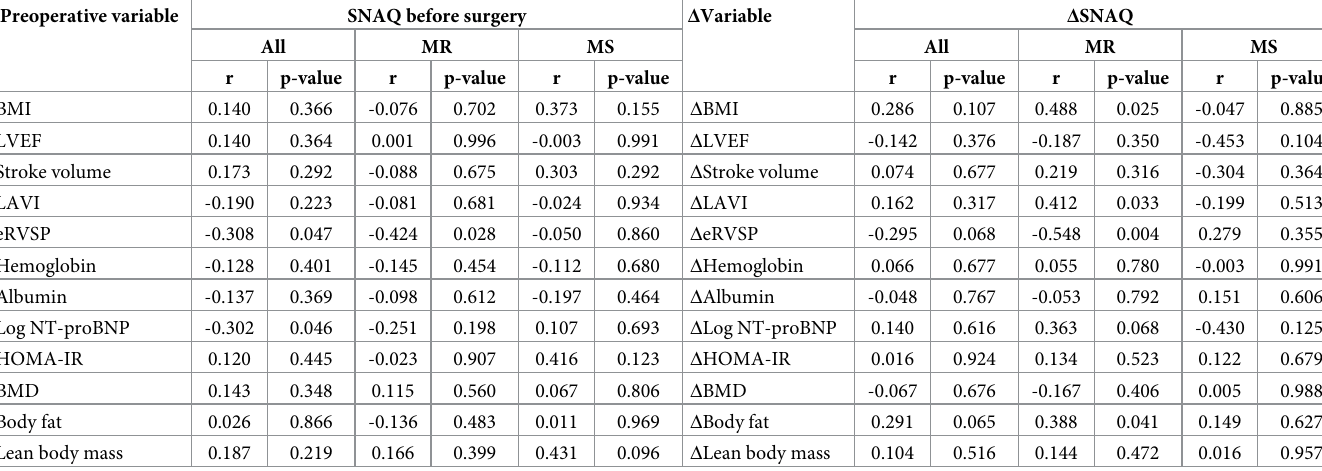
Table 2. Correlation coefficients of short nutrition assessment questionnaire scores before and after mitral valve surgery according to the primary valve lesion. Preoperative variable SNAQ before surgery Δ